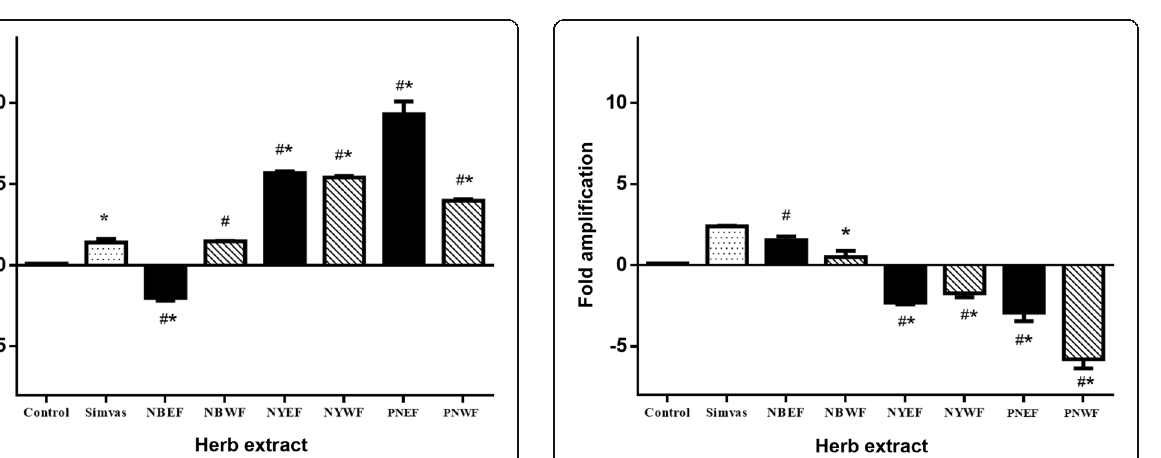
Fig. 7 Effect of all extractions on HMGCR : NBEF, NBWF, NYEF, NYWF, PNEF and PNWF (1 mg/ml each) were individually added to the cells. The expression of HMGCR in HepG2 cells was compared with that in the presence of 1 mg/ml simvastatin and 0.5% DMSO as positive and negative controls, respectively. Bars represent the mean ± SD of independent triplicate experiments. # p < 0.05 compared with NBEF * p < 0.05 compared with